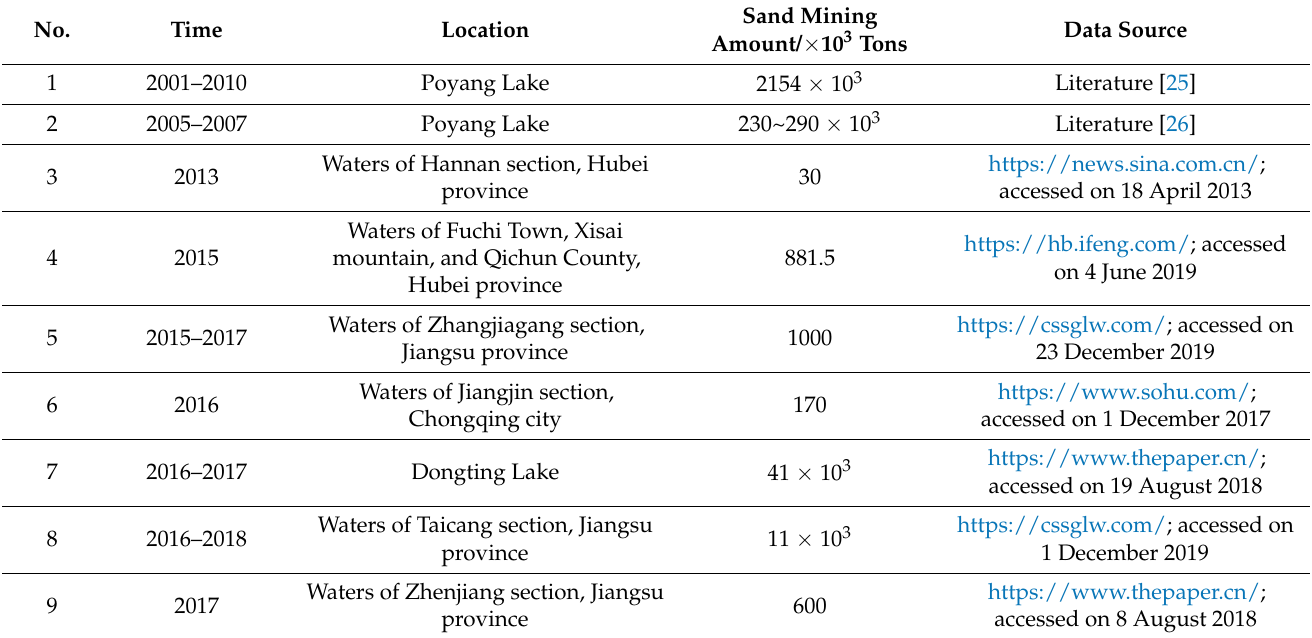
Table 2. Illegal sand mining in